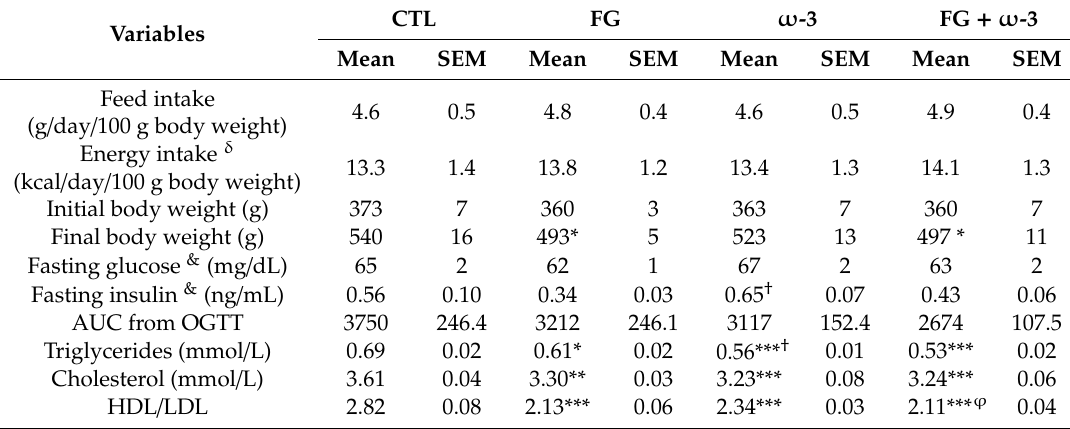
Table 2. Feed and energy intake, body weight, and plasma variables of rats supplemented with d -fagomine and / or ω -3 polyunsaturated fatty acids (PUFAs) for 23 weeks. CTL, control group; FG, group supplemented with d -fagomine; ω -3, group supplemented with ω -3 PUFAs (EPA / DHA 1:1); and FG + ω -3, group supplemented with both d -fagomine and ω -3 PUFAs.